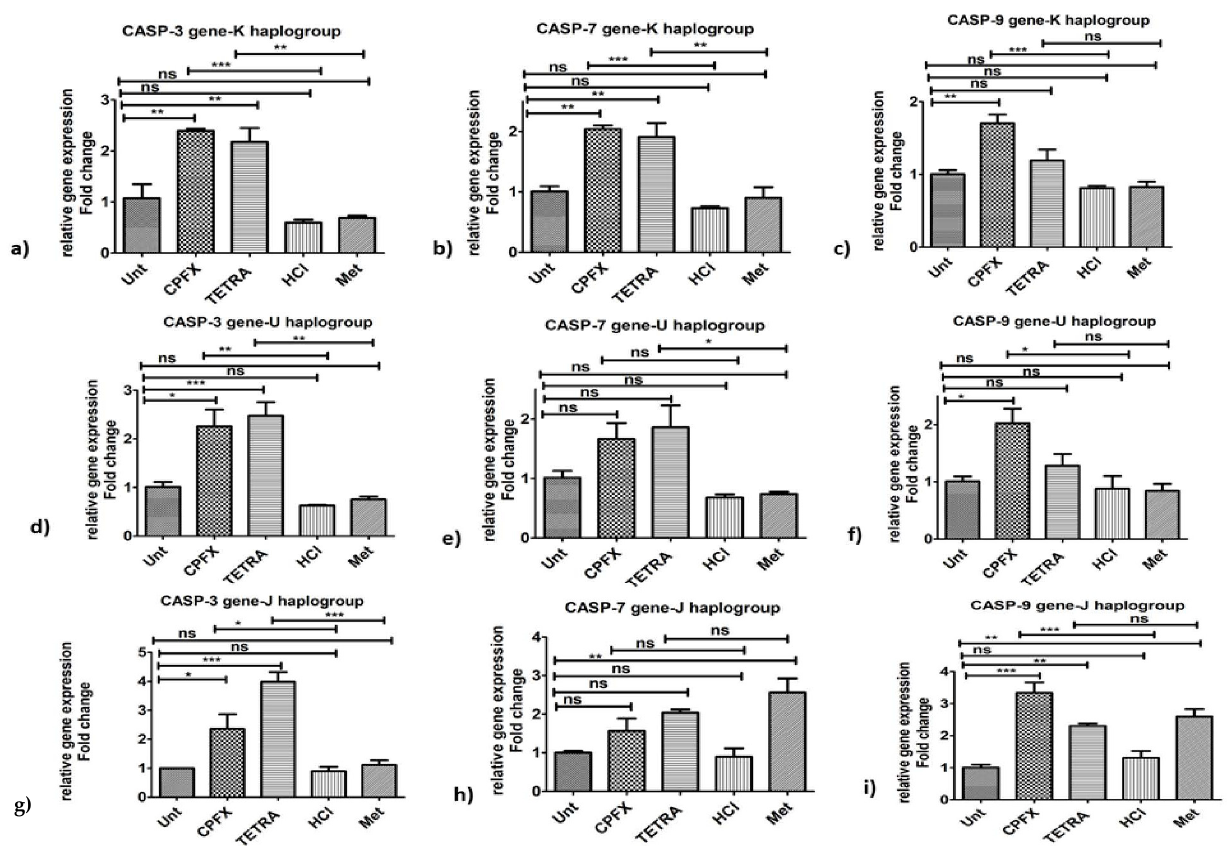
Figure 4. Alterations of pro-apoptotic genes induced by CPFX and TETRA in K, U and J cybrids. Overexpression of CASP-3 ( a , d , g ) via CPFX and TETRA in all three cybrids and upregulation of CASP-7 via CPFX and TETRA in K haplogroup ( b ) and overexpression of CASP-7 by TETRA in U cybrids ( e , h ) and higher CASP-9 ( c , f , i ) expression by CPFX in all three cybrids. (* p < 0.05, ** p < 0.01, *** p < 0.0001).